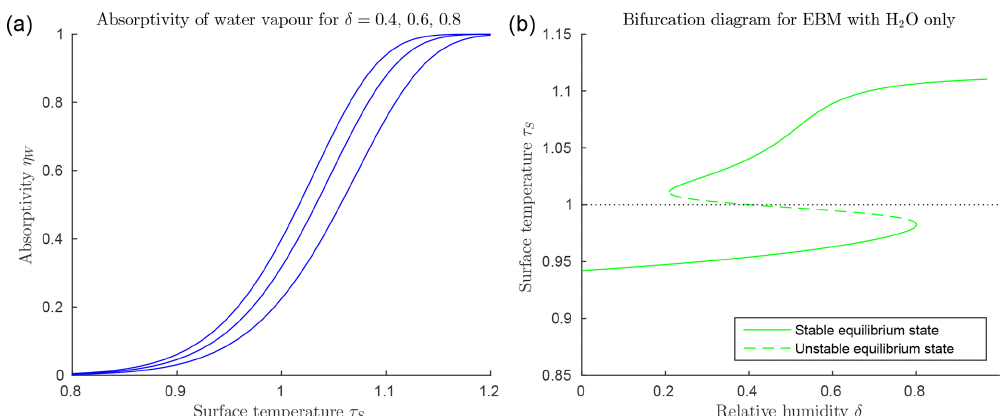
Figure 3. Climate EBM (Eqs. 9–10) including greenhouse effect of water vapour only, µ = 0 (with F A = 45, F O = 50, Q = 173 . 2Wm − 2 , α W = 0 . 08, and Z = 9 km). (a) Absorptivity η W ( τ S ) as given by Eq. (34) with relative humidity δ = 0 . 4 , 0 . 6 and 0 . 8 from bottom to top blue lines. Below freezing ( τ s < 1) water vapour has little influence as a greenhouse gas, but absorptivity increases rapidly to approach η = 1 for τ > 1. (b) Bifurcation diagram for EBM with µ = 0, and relative humidity increasing from 0 to 1. Note the accelerated increase in surface temperature τ S above τ S = 1, compared to that in Fig. 2b, due to the rapid increase in η W